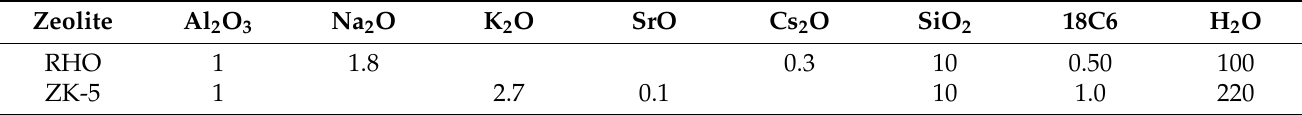
Table 1. Hydrogel batch compositions used to prepare zeolites RHO and